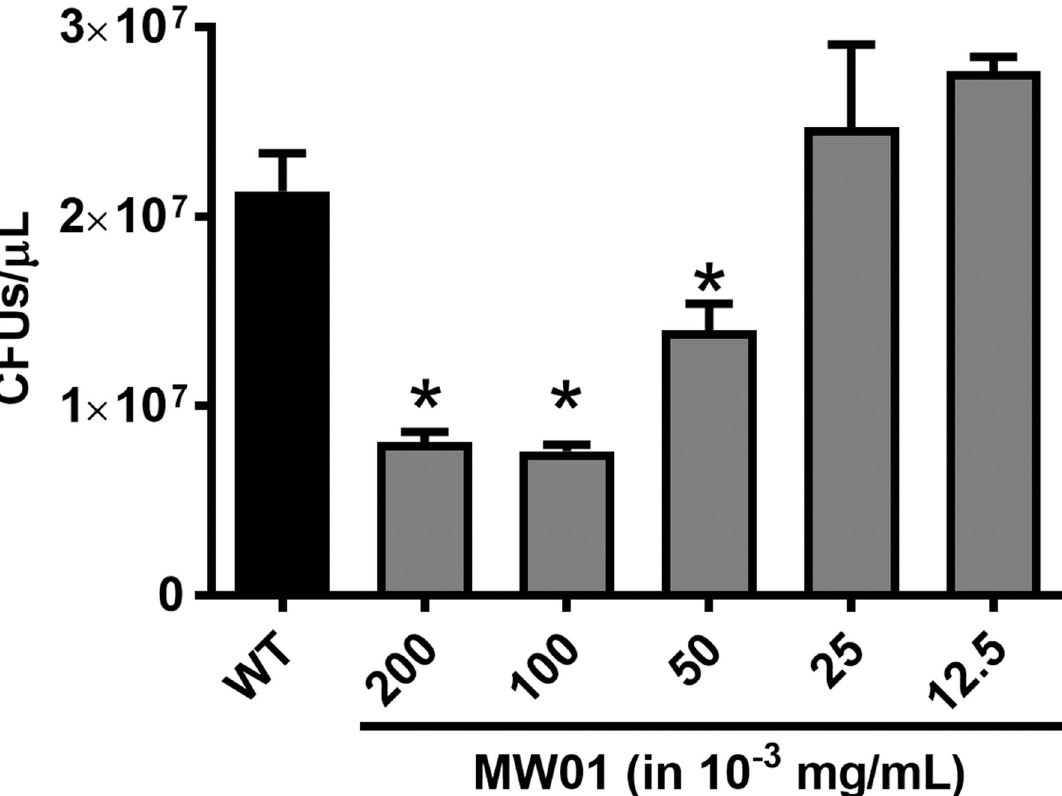
Fig 4. MW01 impedes growth of V . cholerae in early stages (within the first four hours) of bacterial culture. V . cholerae cells were first exposed to MW01 in LB broth for four hours at 27˚C in a setup that mimicked the initiation of biofilm cultures in borosilicate tubes. Then, after identical series of ten-fold dilutions, 10 μ L of each broth culture was plated on LB agar and incubated overnight at 37˚C. Wild-type V . cholerae (WT) not exposed to MW01 served as control. � denotes statistical significance (p < 0 . 05) from control